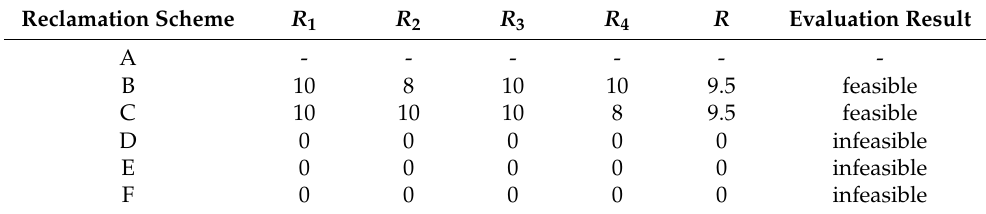
Table 16. Feasibility evaluation on EC (scenario 2).